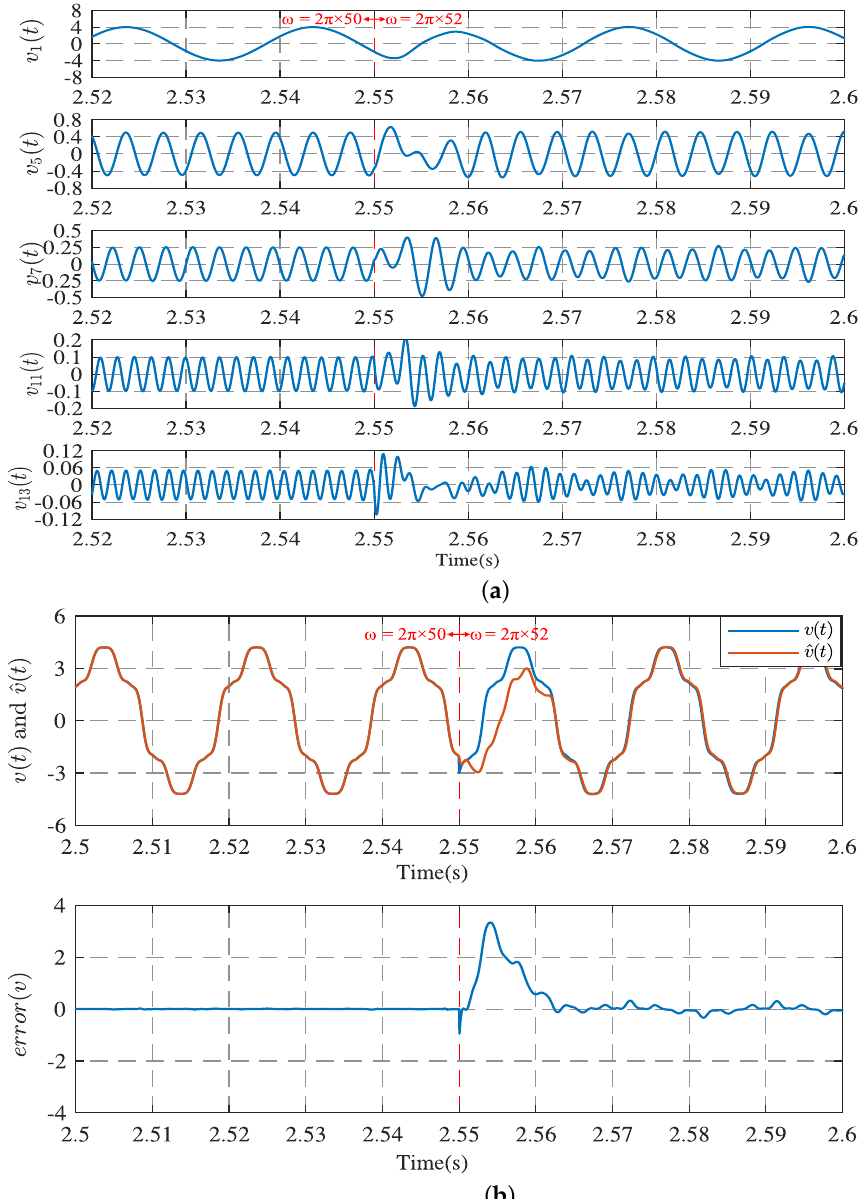
Figure 14. Experimental results: ( a ) The effect of extracting each harmonic after a jump in the fundamental frequency of the input signal; ( b ) Comparison of the results of the observer with the real signal and the error